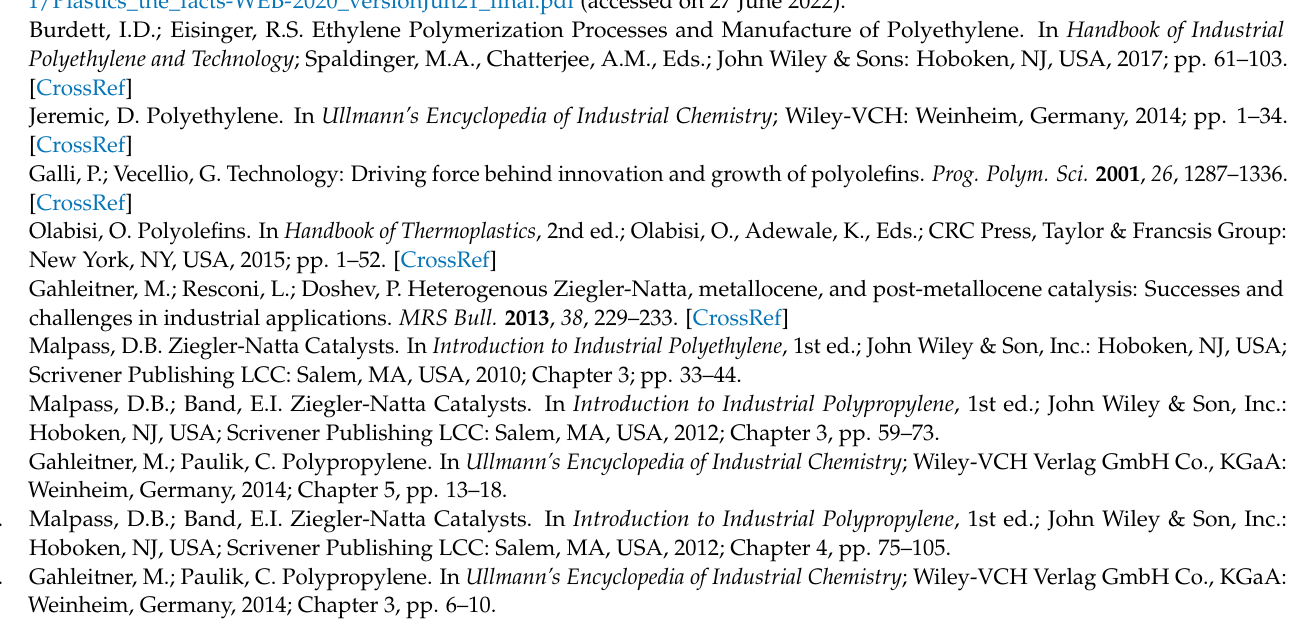
article; Table S3: Data for Figure 4 for the viscosity profile of a 33.2% BEM solution in heptane and different additive concentrations; Figure S1: Molecular weight distribution for the obtained polymers measured with HT-SEC; Figure S2: Schematic drawing of the 0.5 L reactor setup used for the polymerization